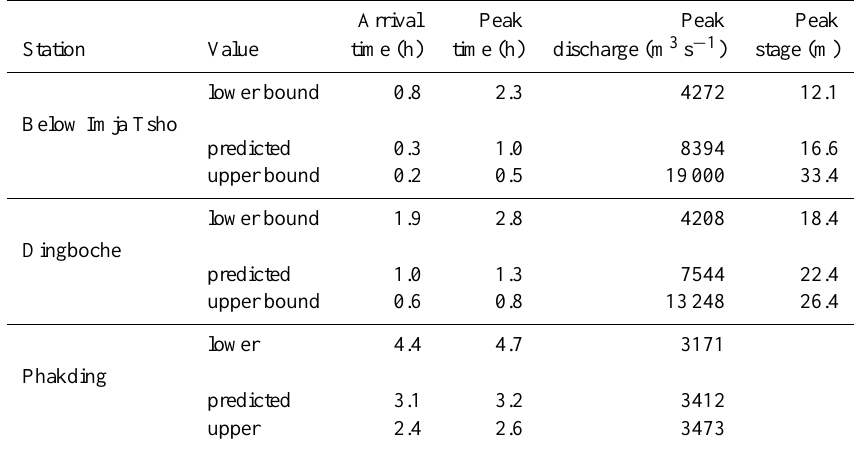
Arrival Peak Peak Peak